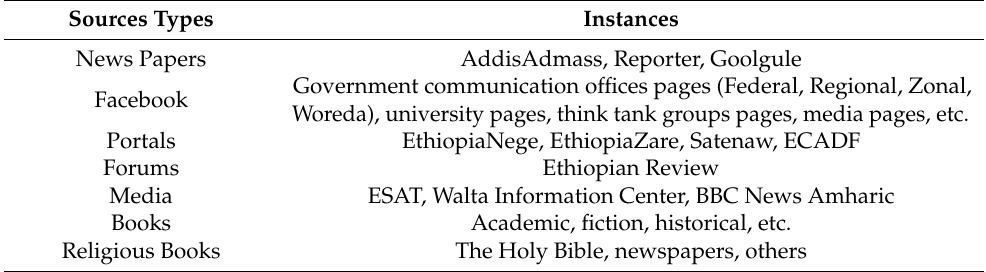
Table 2. Data sources for the general-purpose Amharic corpus (GPAC).